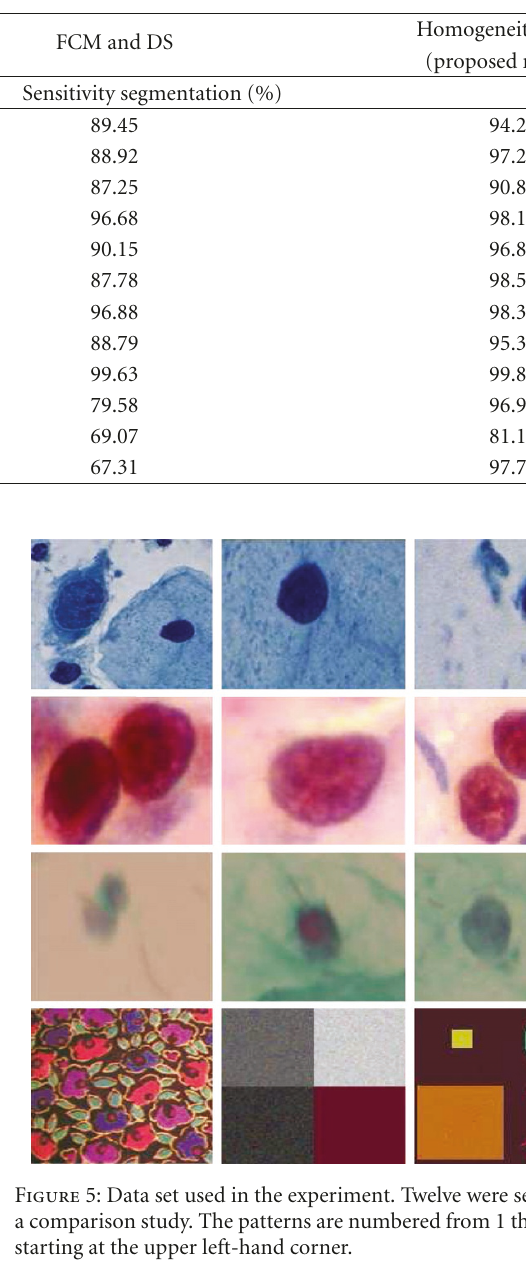
Table 2: Segmentation sensitivity from HCM and DS, FCM and DS and homogeneity method and DS for the data set shown in Figure 5.